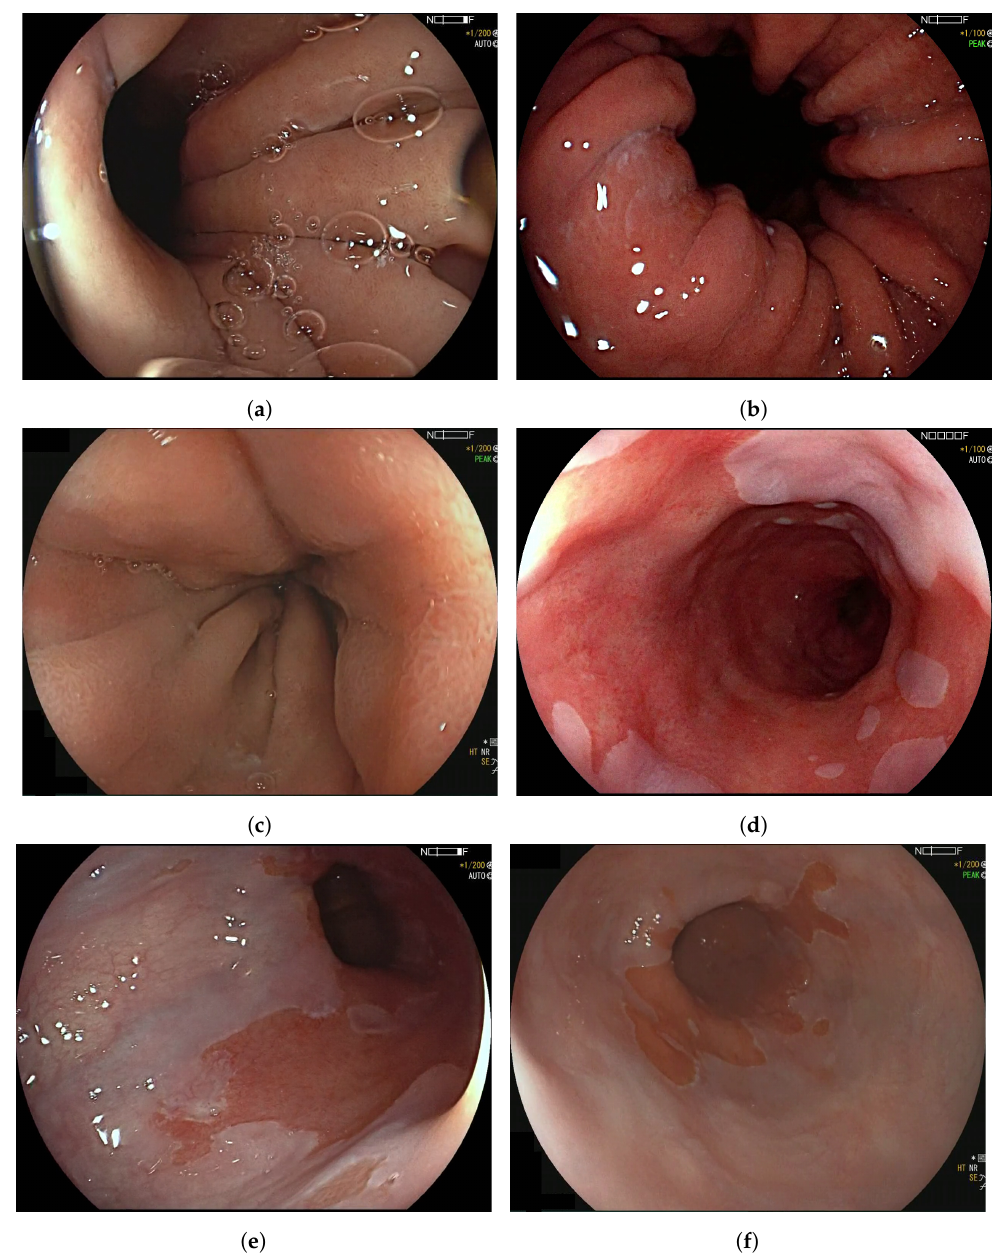
Figure A1. Examples of images with similar imaging features, which are lacking a hard definable border for a classification label. ( a – c ) contain images that represent the transition area from stomach to the Barrett’s esophagus, which all contain features, like gastric folds, and ( a , b ) also include a view into the stomach. ( d – f ) contain representations seen around the transition from Barrett’s esophagus to healthy squamous tissue, which all contain visual features from the Barrett’s esophagus and squamous tissue. ( a ) Cardia of the stomach labeled as ‘Stomach’. ( b ) Image captured after the esophageal sphincter labeled as ‘transition Z-line’. ( c ) Contracted Barrett’s esophagus labeled as ‘Barrett’. ( d ) Barrett’s esophagus with healthy squamous tissue falling into the field of view labeled as ‘Barrett’. ( e ) Transition zone between Barrett’s esophagus and healthy squamous tissue, labeled as ‘transition squamous. ( f ) Mostly squamous tissue, with Barrett’s esophagus in the background, labeled as